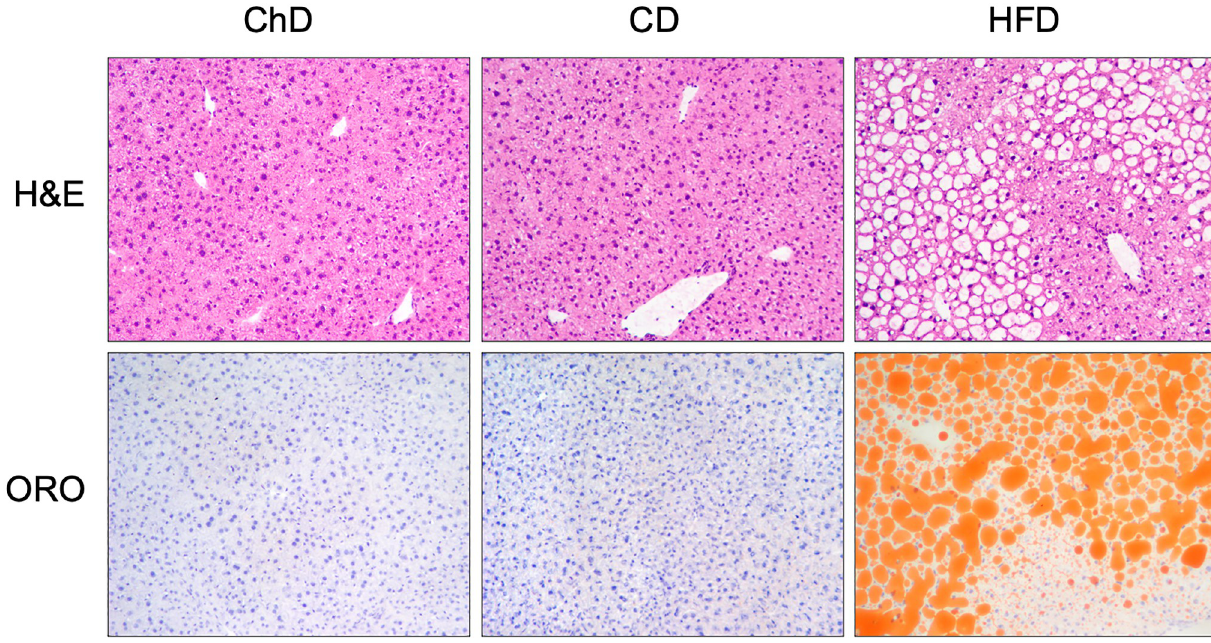
Fig 2. Hepatic steatosis in C57BL/6 mice fed a HFD. Livers from mice fed the CD or ChD diet showed no lipid accumulation. Mice fed the HFD had marked extensive macrovesicular steatosis. Hematoxylin & eosin, 100x; Oil Red O, 100x.